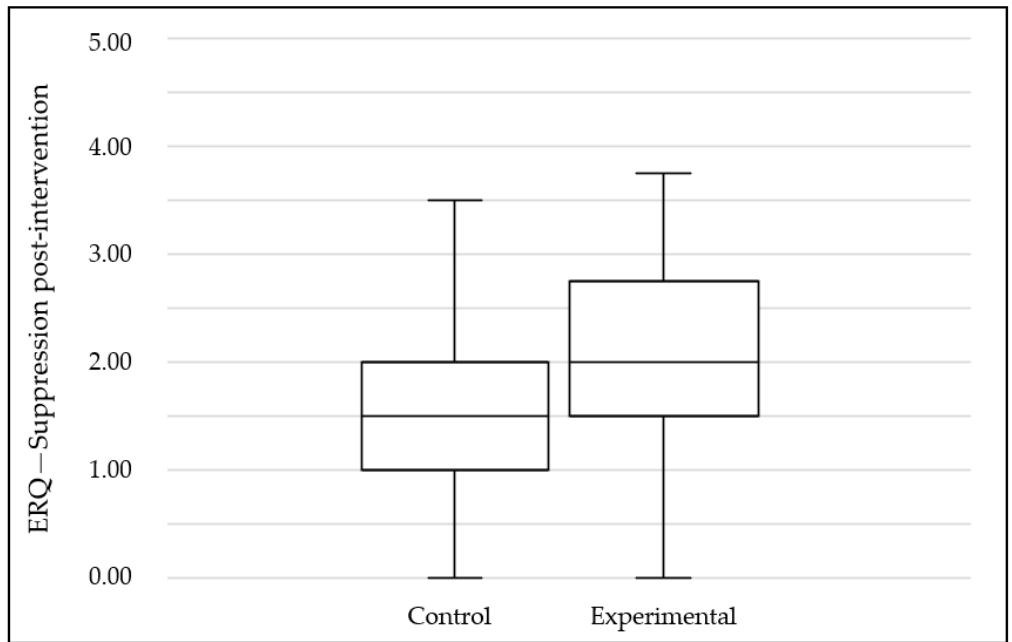
Figure 3. Mean scores for ERQ — Suppression subscale at post-intervention by groups.